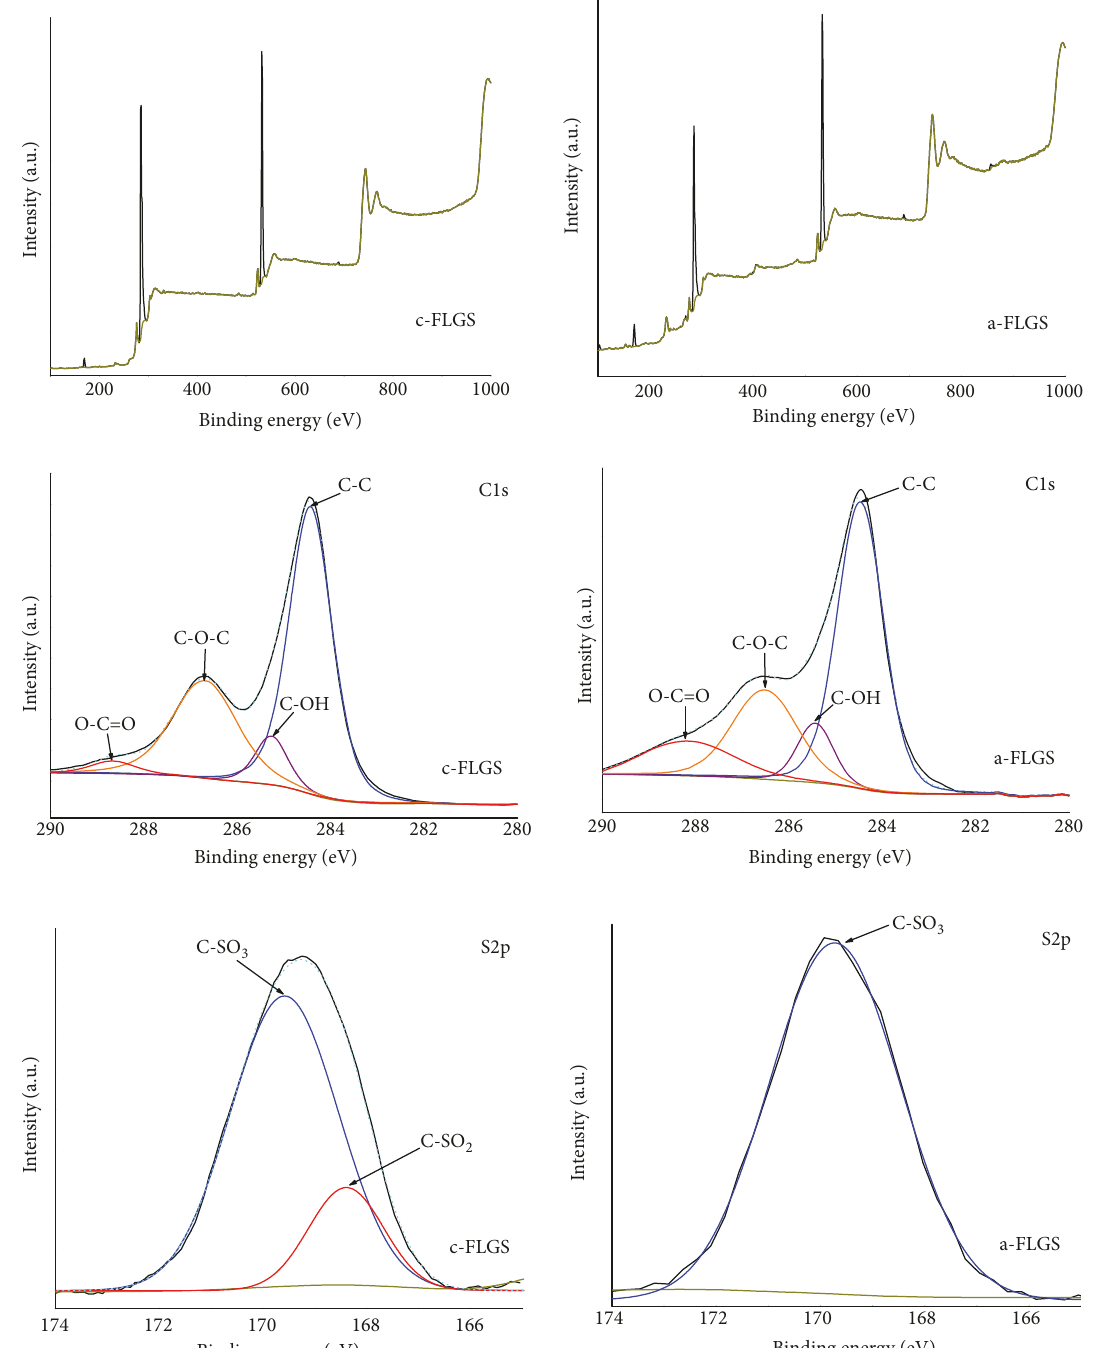
Figure 3: Survey spectra (a, d), high resolution XPS for C1s (b, e), and S2p (c, f) of c-FLGS (a–c) and a-FLGS (d–f).